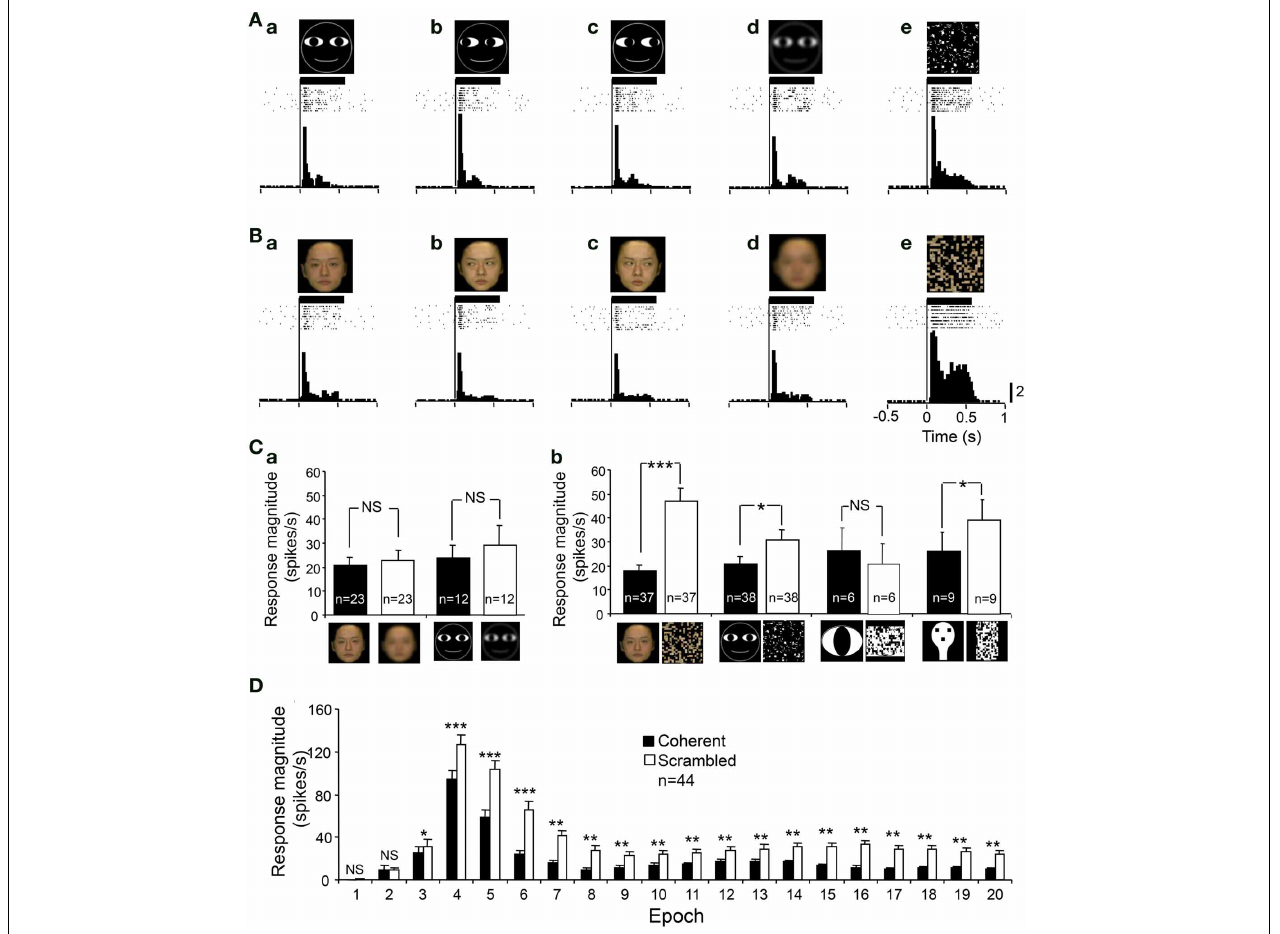
FIGURE 6 | An example of a sSC neuron tested with the scrambled and low spatial images. (A) The neuron responded to the cartoon faces (Aa–c) . The neuron responded similarly to the low spatial frequency (LSF)-pass filtered image (Ad) , but more strongly to the scrambled image (Ae) . (B) The neuron responded to the human frontal faces (Ba–c) . The neuron responded similarly to the LSF-pass filtered image (Bd) , but more strongly to the scrambled image (Be) . Calibration at the right bottom of